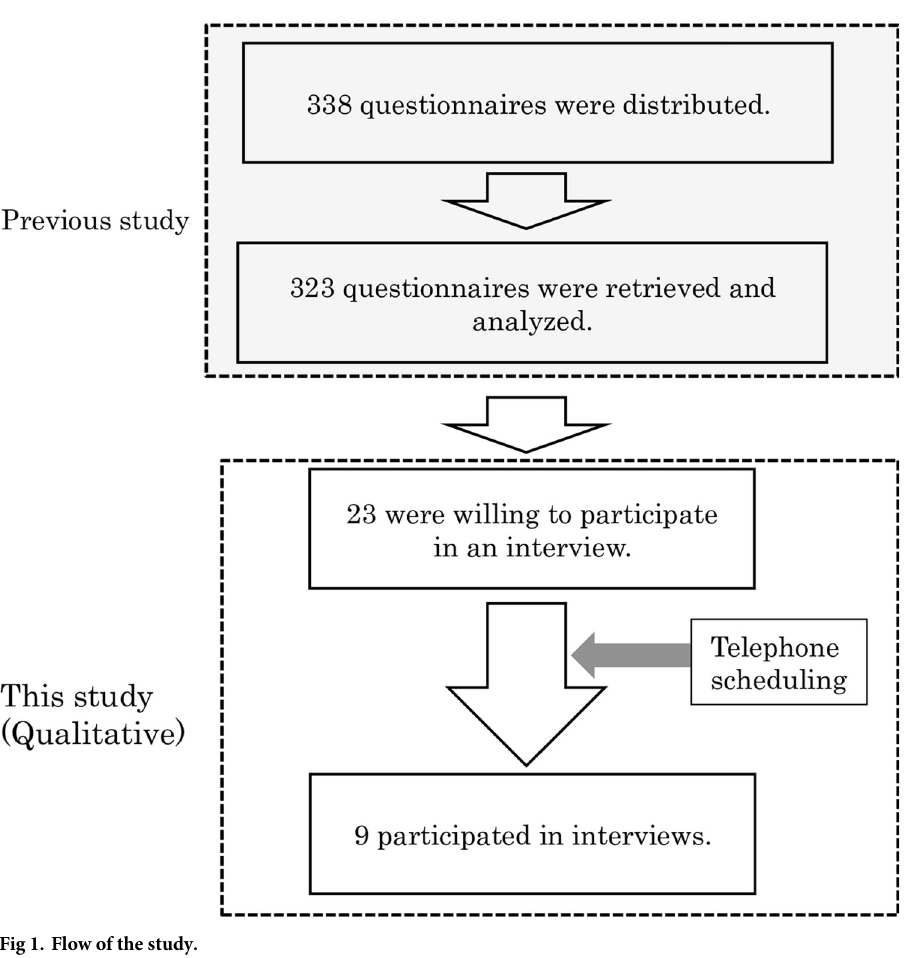
Fig 1. Flow of the study.